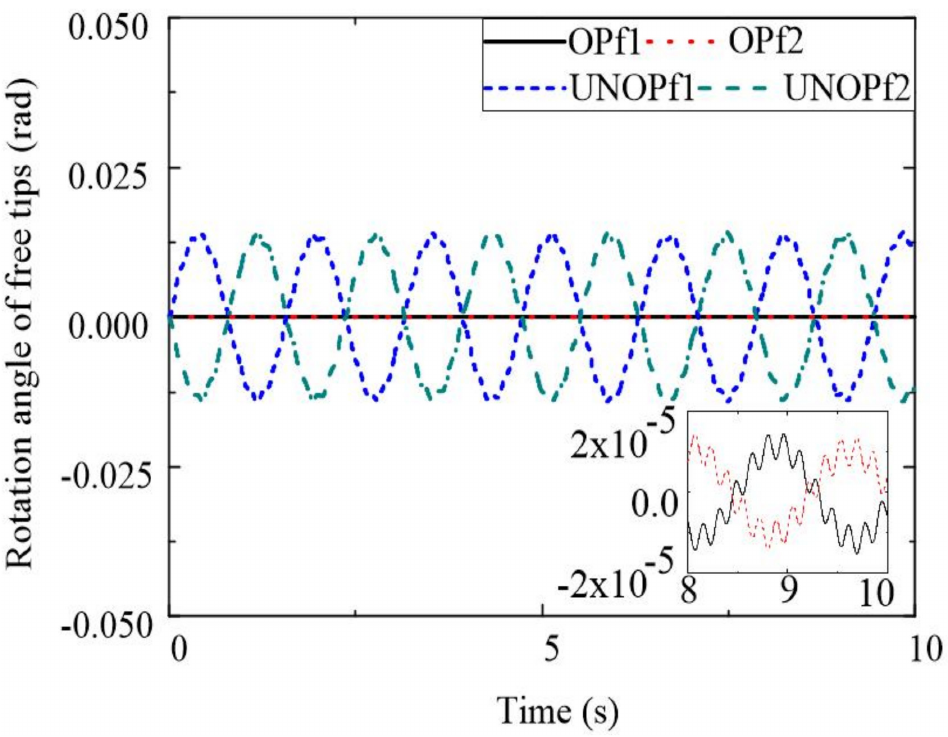
Figure 24. Rotation angles of the tips of the beams during the trajectory tracking stage.